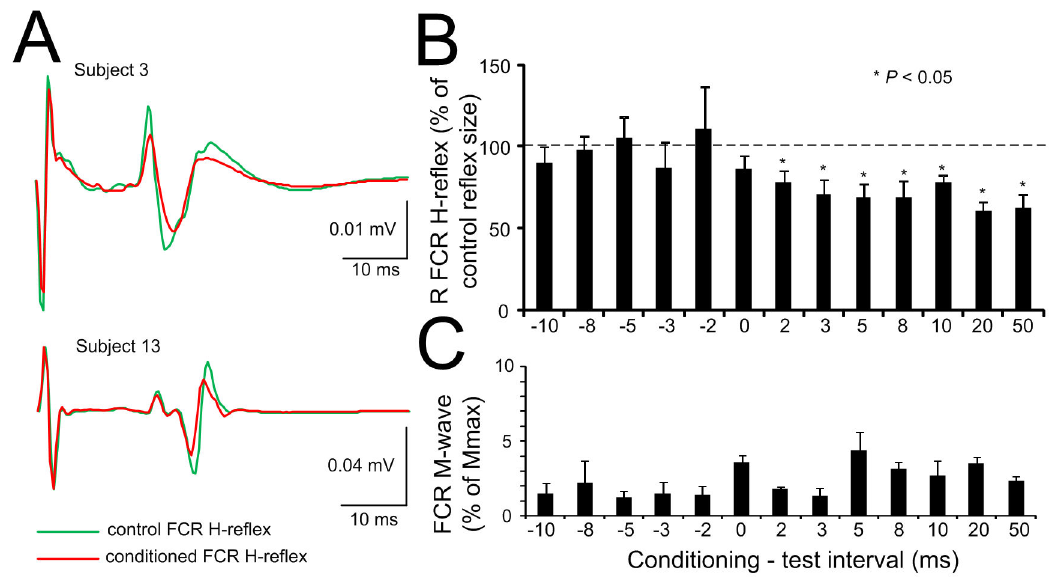
Figure 7. Effects of non-invasive cervicothoracic transpinal on FCR H-reflexes. A : Non-rectified waveform averages of the FCR H-reflex in two subjects under control conditions and following transcutaneous electric stimulation of the spine (tsESS) at the conditioning-test interval of 2 ms. Note that the FCR H-reflex depression occurs with stable M-waves. B : Overall average amplitude of the FCR H-reflex conditioned by tsESS as a percentage of the control H-reflex. Asterisks indicate statistically significant differences between the conditioned and the control FCR H-reflex. C : Overall average amplitude of the FCR M-wave. Error bars indicate the SEM.